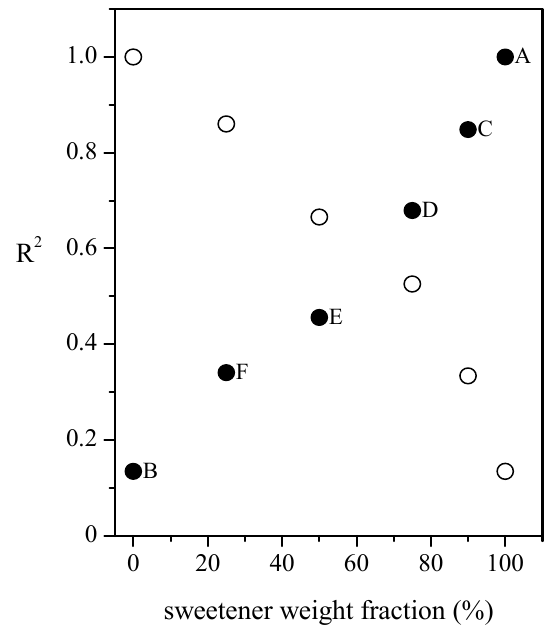
Figure 4. R 2 coefficient values (95% confidence level) for the linear regression of Raman spectra of different glucose/sweetener mixtures as a function of the sweetener weight fraction (in %). Filled dots represent the values obtained by using the bare sweetener signal (from sample A) as reference. With empty dots the results obtained by using the pure glucose spectrum (from sample B) as reference are